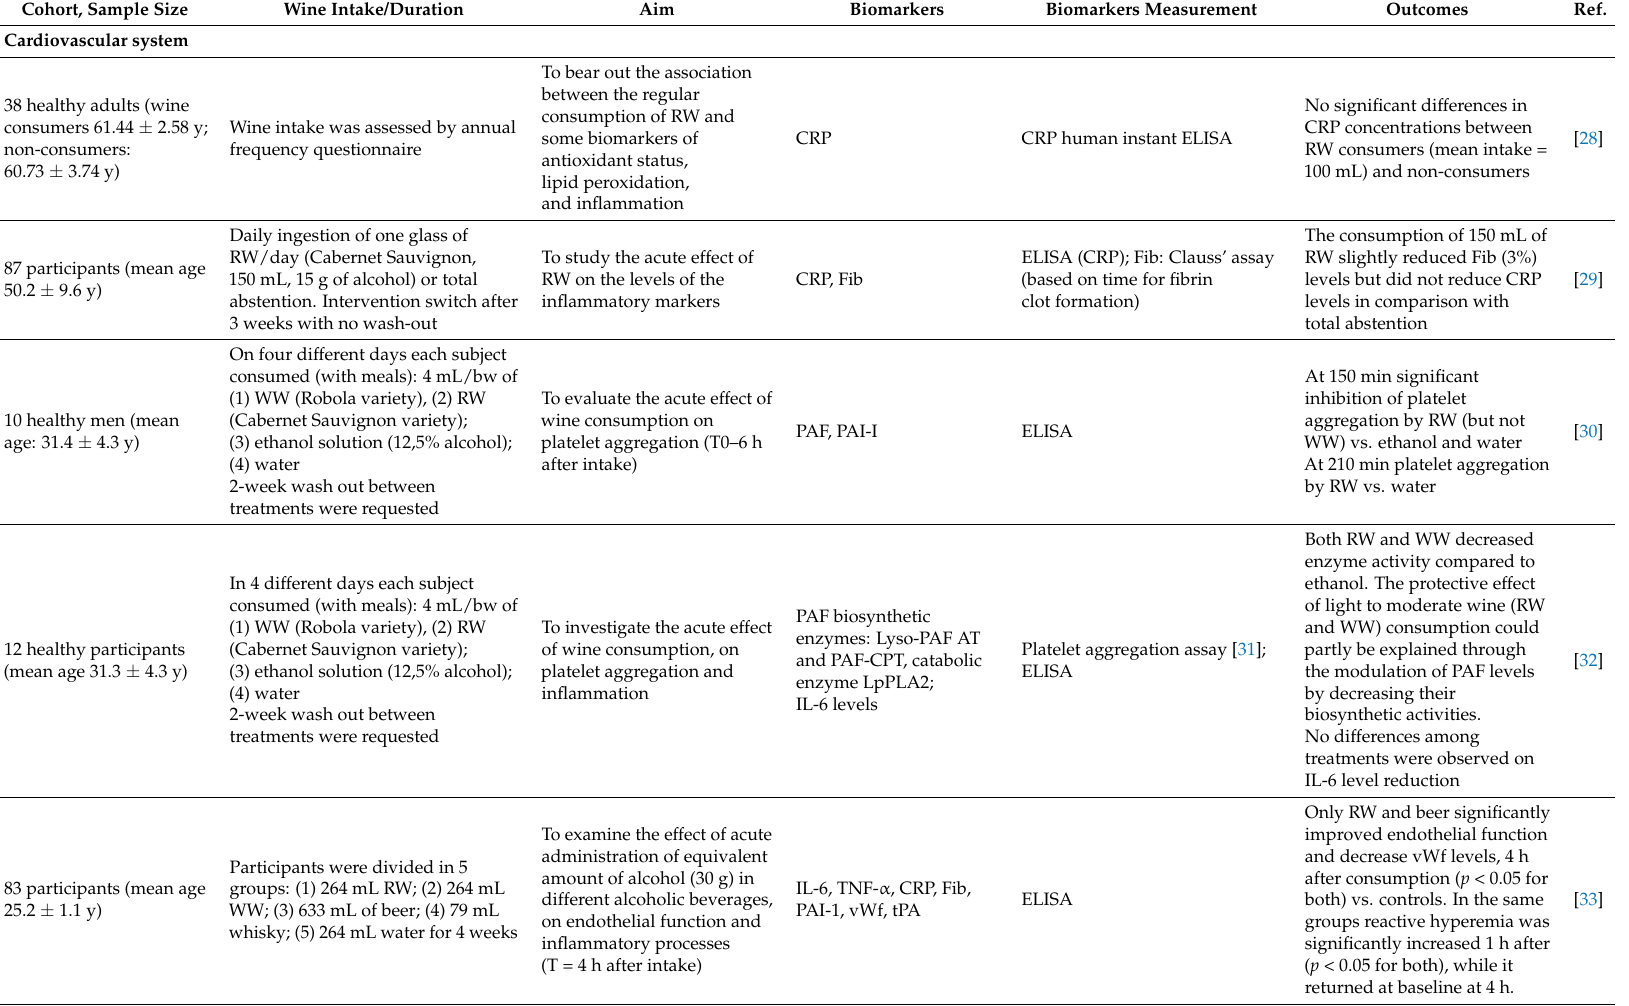
Table 3. Summary of the collected human trials to assess effects of wine on inflammation